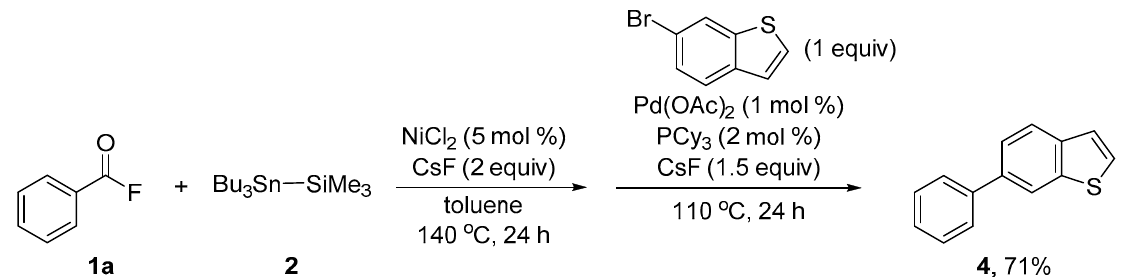
Table 2. Decarbonylative stannylation of acyl fluorides a,b